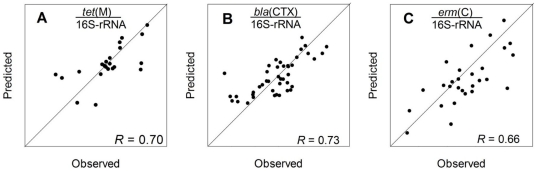
Comparison of multi-linear regression predictions and observed relative abundances of A) tet(M), B) bla
CTX-M and C) erm(F) genes.Factors entered into the regression included: total chromium, copper, nickel, lead, extractable iron, and pH.